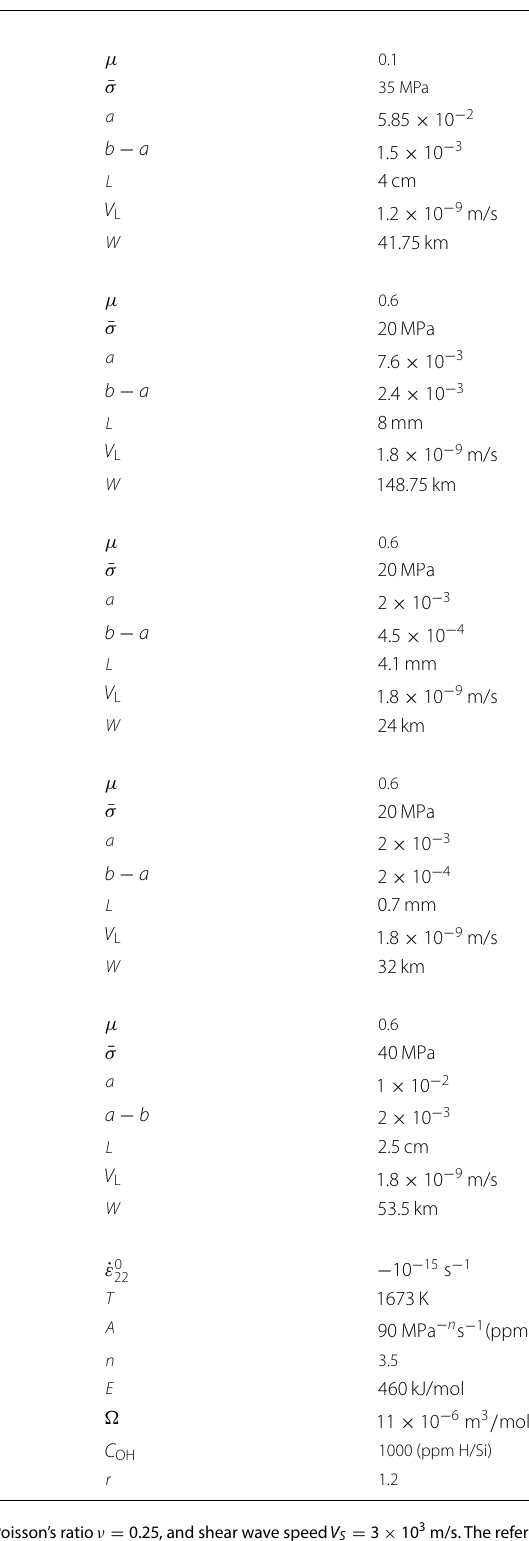
Table 1 Summary of the physical parameters controlling fault dynamics and viscoelastic